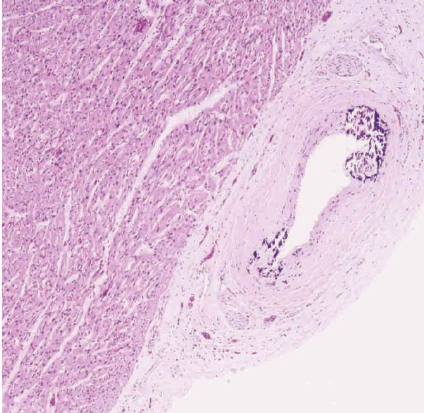
Figure 3: Microscopic picture from the left coronary artery focally demonstrates calcification of the internal elastic lamina (hematoxylin-eosin, original magnification × 200).